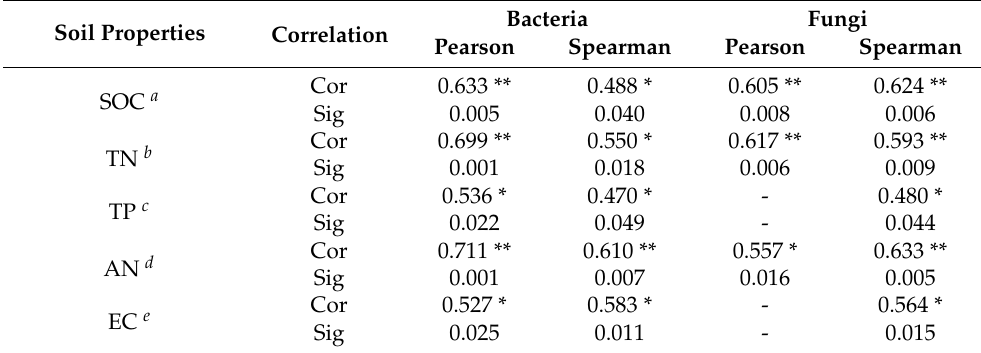
Table 3. Spearman’s and Pearson’s analyses of correlation between soil microbial abundance and soil abiotic properties of long-term cucumber monoculture in greenhouse conditions.